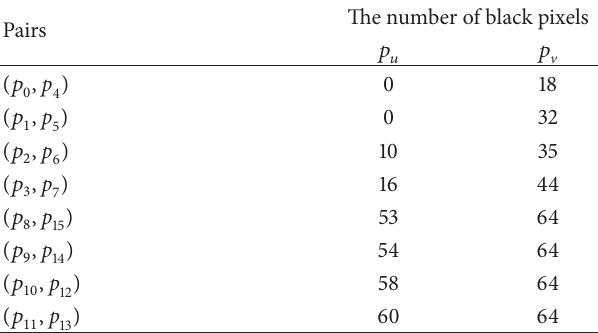
Table 2: The black pixel numbers in eight pairs of the top-left subimage in Figure